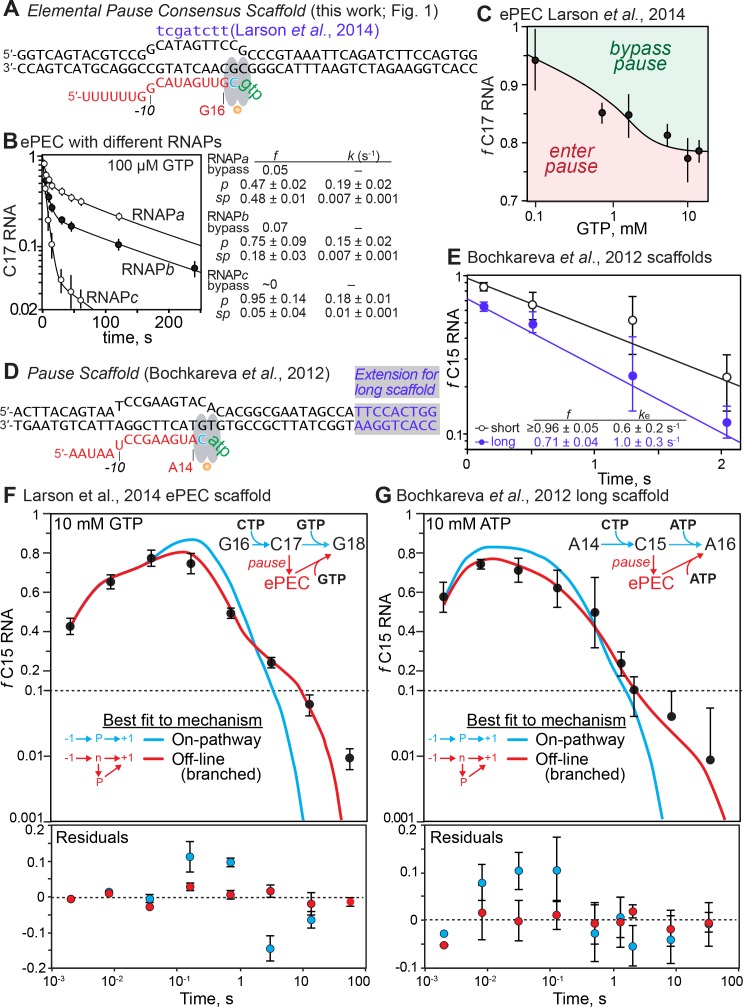
The elemental pause is a distinct offline state, not an on-pathway elongation intermediate.(A) The complete consensus elemental pause scaffold (ntDNA #9563, tDNA #8334, RNA #8342; Supplementary file 1), identical to that used in Larson et al. (2014), except the template and nontemplate DNA strands are fully complementary (the noncomplementary, nontemplate strand bases in the Larson et al. scaffold are indicated in purple; ntDNA #8333). (B) Pause RNA as a function of time and kinetic fractions for three different RNAP preparations. (C) Effect of GTP concentration on partition of C17 between bypass and pause states in experiments also reported in Larson et al. (2014). (D) The pause scaffold defined by Bochkareva et al. (2012) (black; ntDNA #8195, tDNA #8196, RNA, #7974; Supplementary file 1) and the 10 bp downstream duplex extension to move the duplex end outside the RNAP footprint (purple on gray background; black; ntDNA #8289, tDNA #8196). Steps in a minimal pause assay and the constrained offline pause pathway (red) are shown on the right. (E) Estimation of pause fractions and apparent pause escape rates at 10 mM ATP for the Bochkareva et al. scaffold with (long) and without (short) the additional 10 bp downstream duplex. (F) Best fit by numerical integration and residuals for on-pathway (unbranched) and off-line mechanisms for the consensus ePEC scaffold (panel A) at 10 mM GTP. The fits shown were calculated using the average of data from three experimental repeats, including error (SD) in the fitting. The residuals were calculating by performing individual fits to the three replicate datasets and then averaging and calculating SD for the residuals for each fit. The sinusoidally varying residuals for the unbranched mechanism vs. their random and within-error variation for the branched mechanism establishes that pausing occurs by the branched mechanism. (G) Best fit by numerical integration and residuals for on-pathway (unbranched) and off-line (distinct pause species at C15) mechanisms for the Bochkareva et al. (2012) ePEC scaffold (panel B) at 10 mM ATP. The fits and residuals were calculated as described for panel E, except that data from six experimental repeats were used, and by the same reasoning establish that pausing occurs by the branched mechanism.